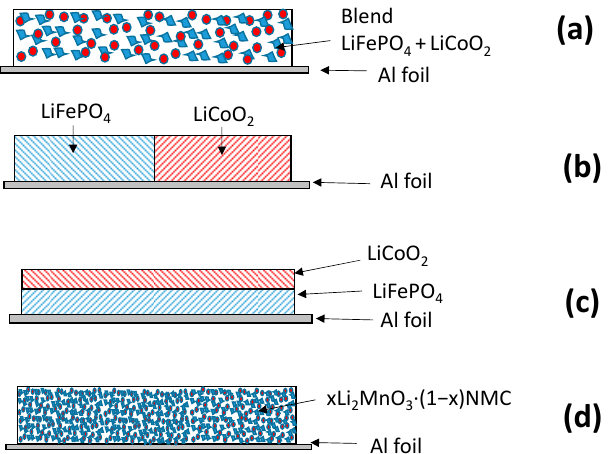
Figure 1. Scheme of the four different configurations of blended cathodes: ( a ) completely intermixed, ( b ) segregated, ( c ) layered, and ( d ) integrated cathode.